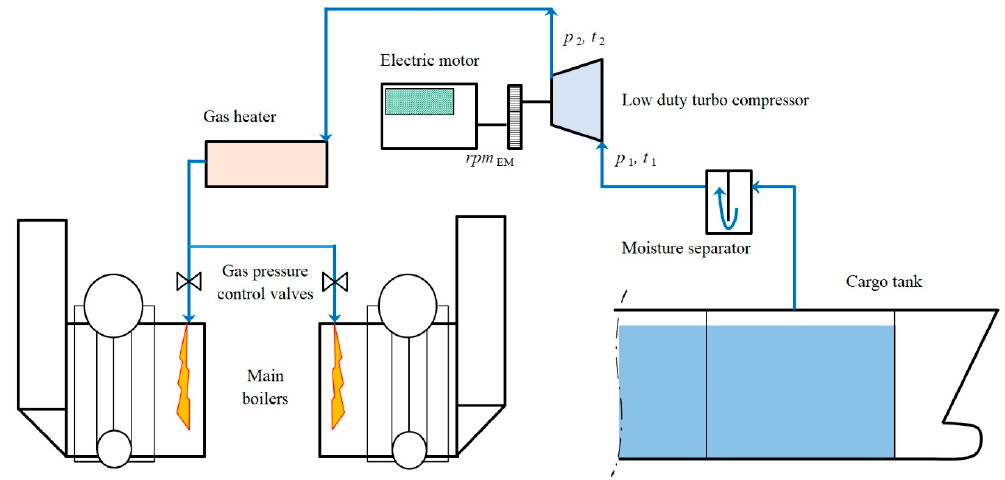
Figure 1. Natural gas supply with low-duty turbo compressor on a conventional liquid natural gas (LNG) carrier .